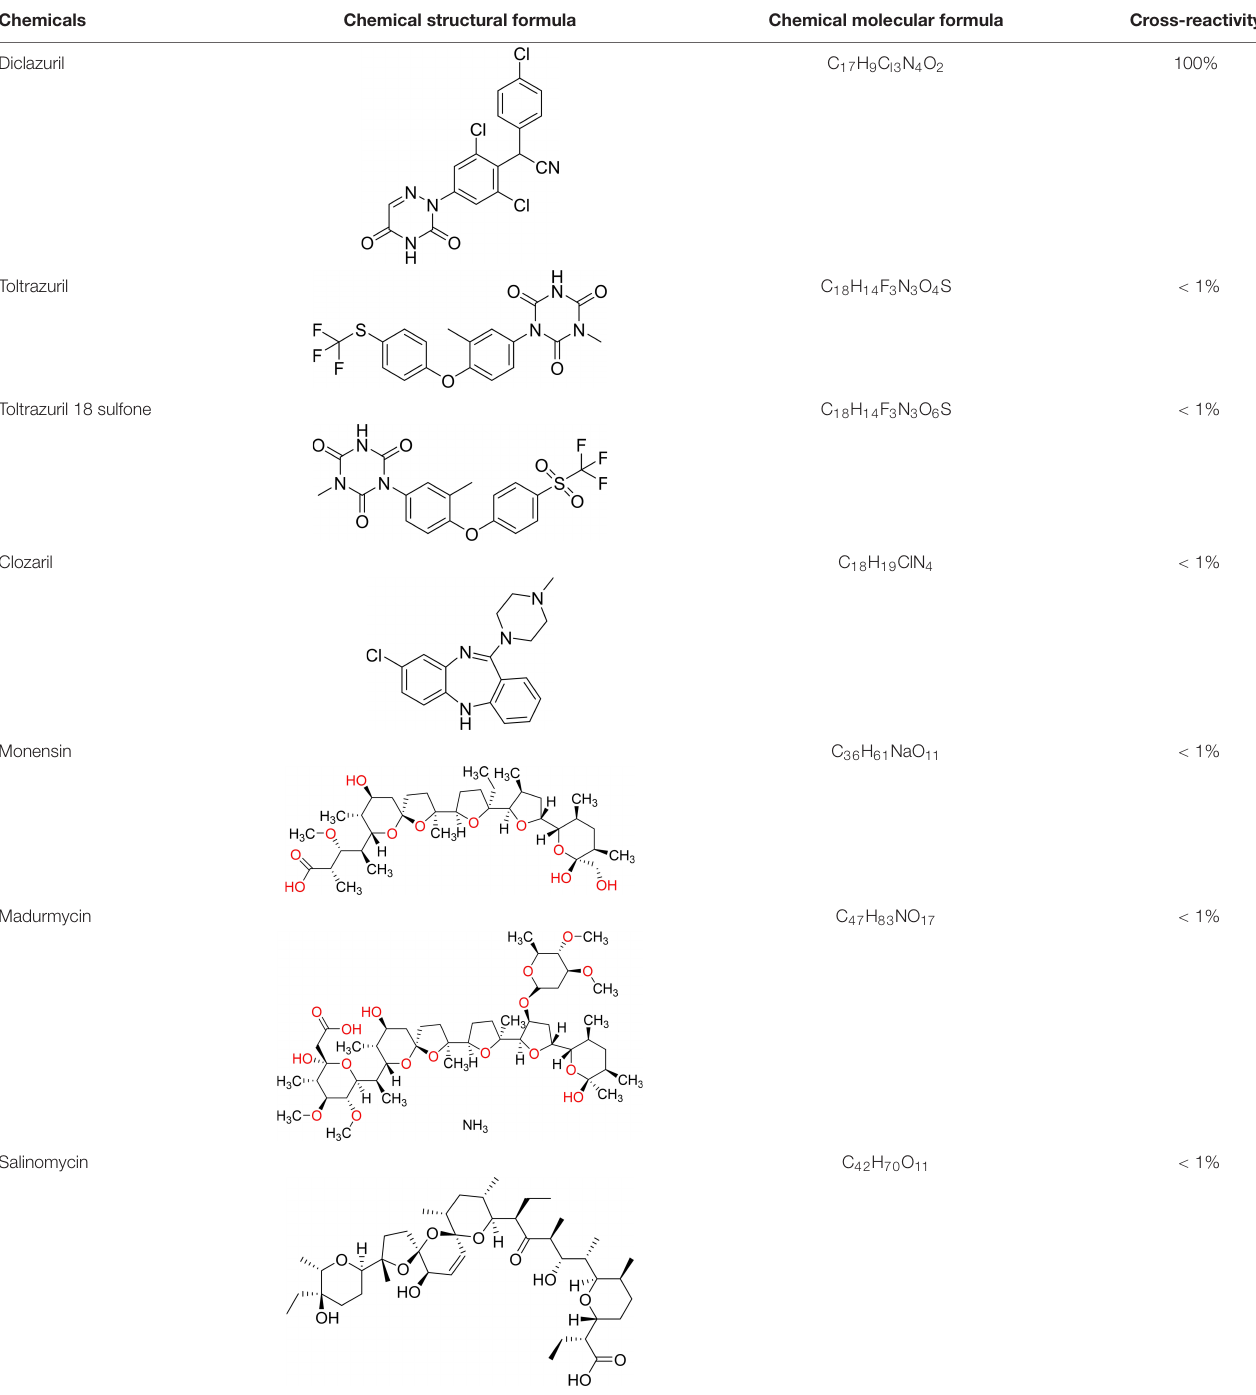
TABLE 2 | The cross-reaction rate of diclazuril antibody. Chemicals Chemical structural formula Chemical molecular formula